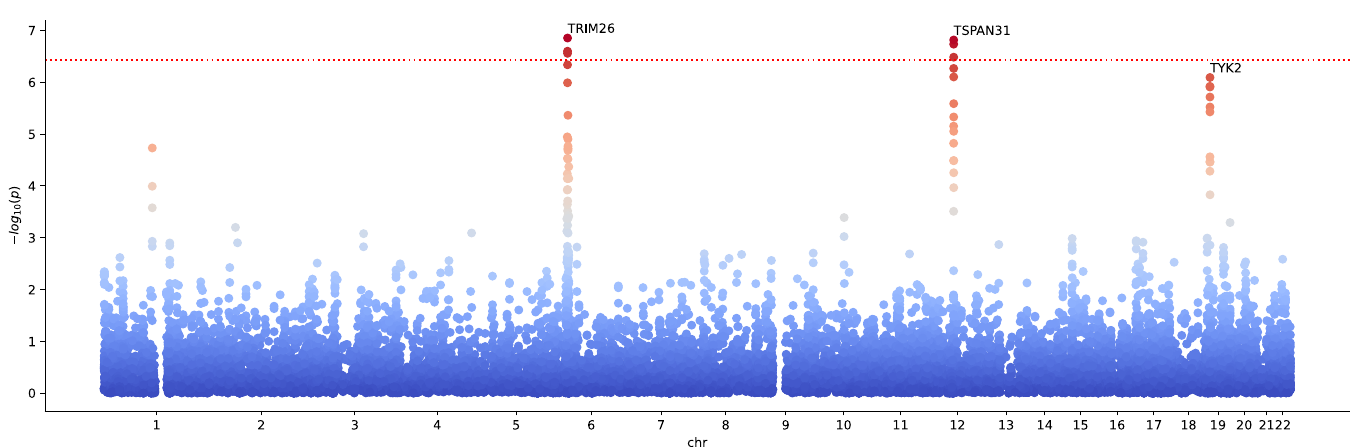
Fig 8. Manhattan plot for cross-scoring severe confirmed COVID-19 with rheumatoid arthritis for anti-coherence. Data points correspond to genes. The dotted red line marks a Bonferroni significance threshold of 3.9 × 10 − 7 (0.05 divided by the 18453 genes tested and 7 traits). The labels denote the leading gene hit for the corresponding